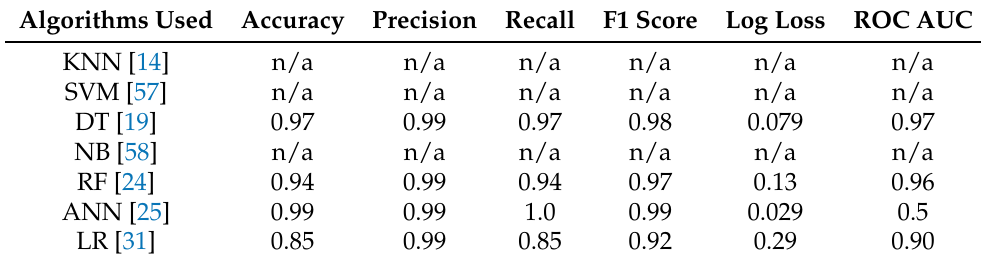
Table 30. Service scan weighted classes